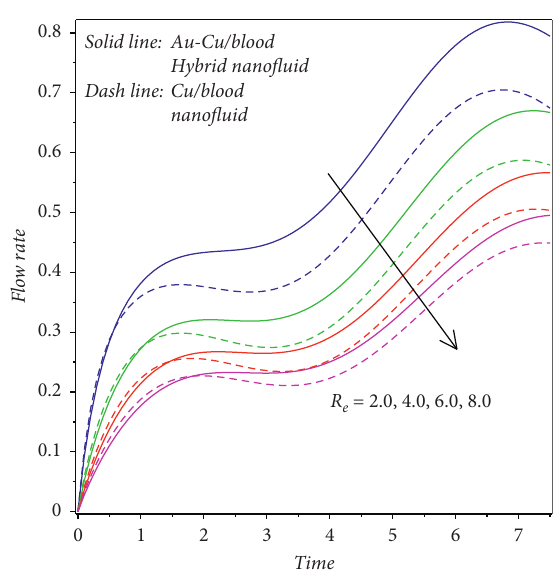
Figure 17: Behaviour of α on Q